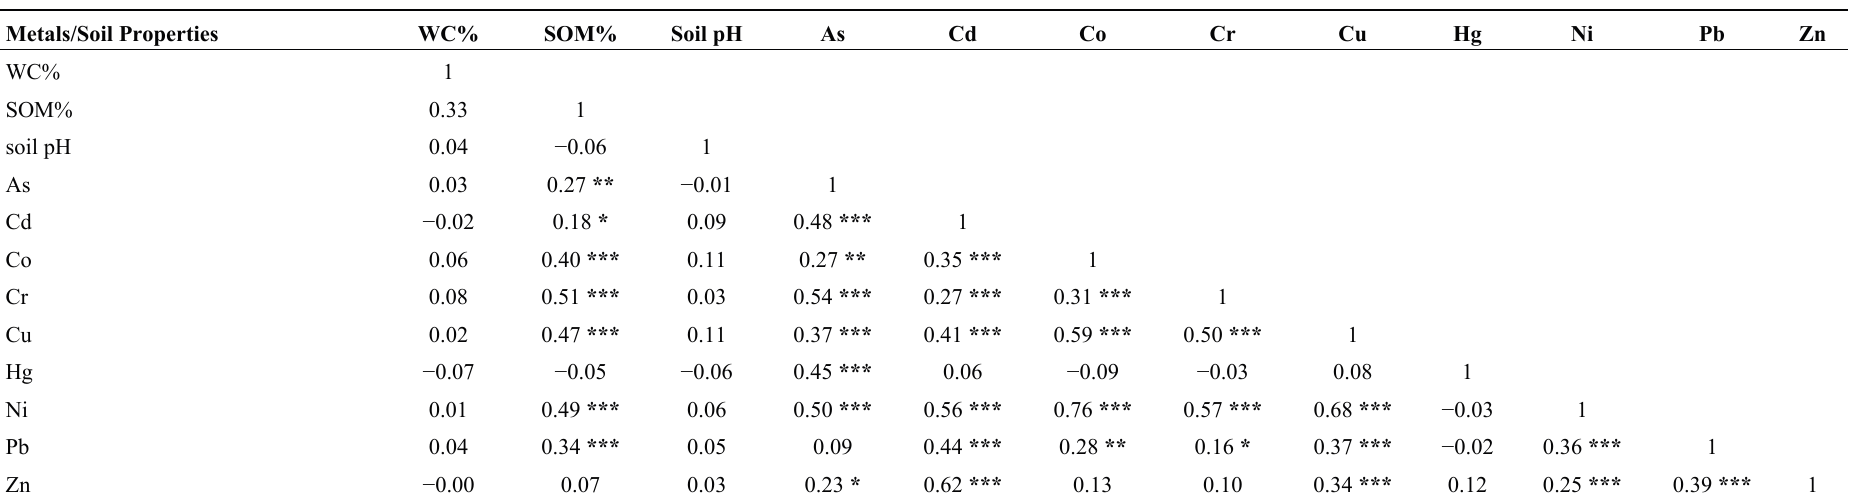
Table 2. Pearson’s correlation matrix of heavy metals and soils properties in